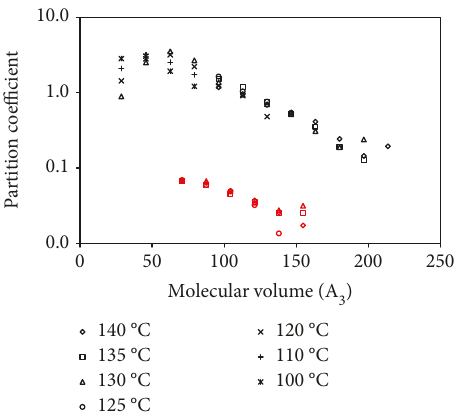
(black dots: n -alkanes; g/b